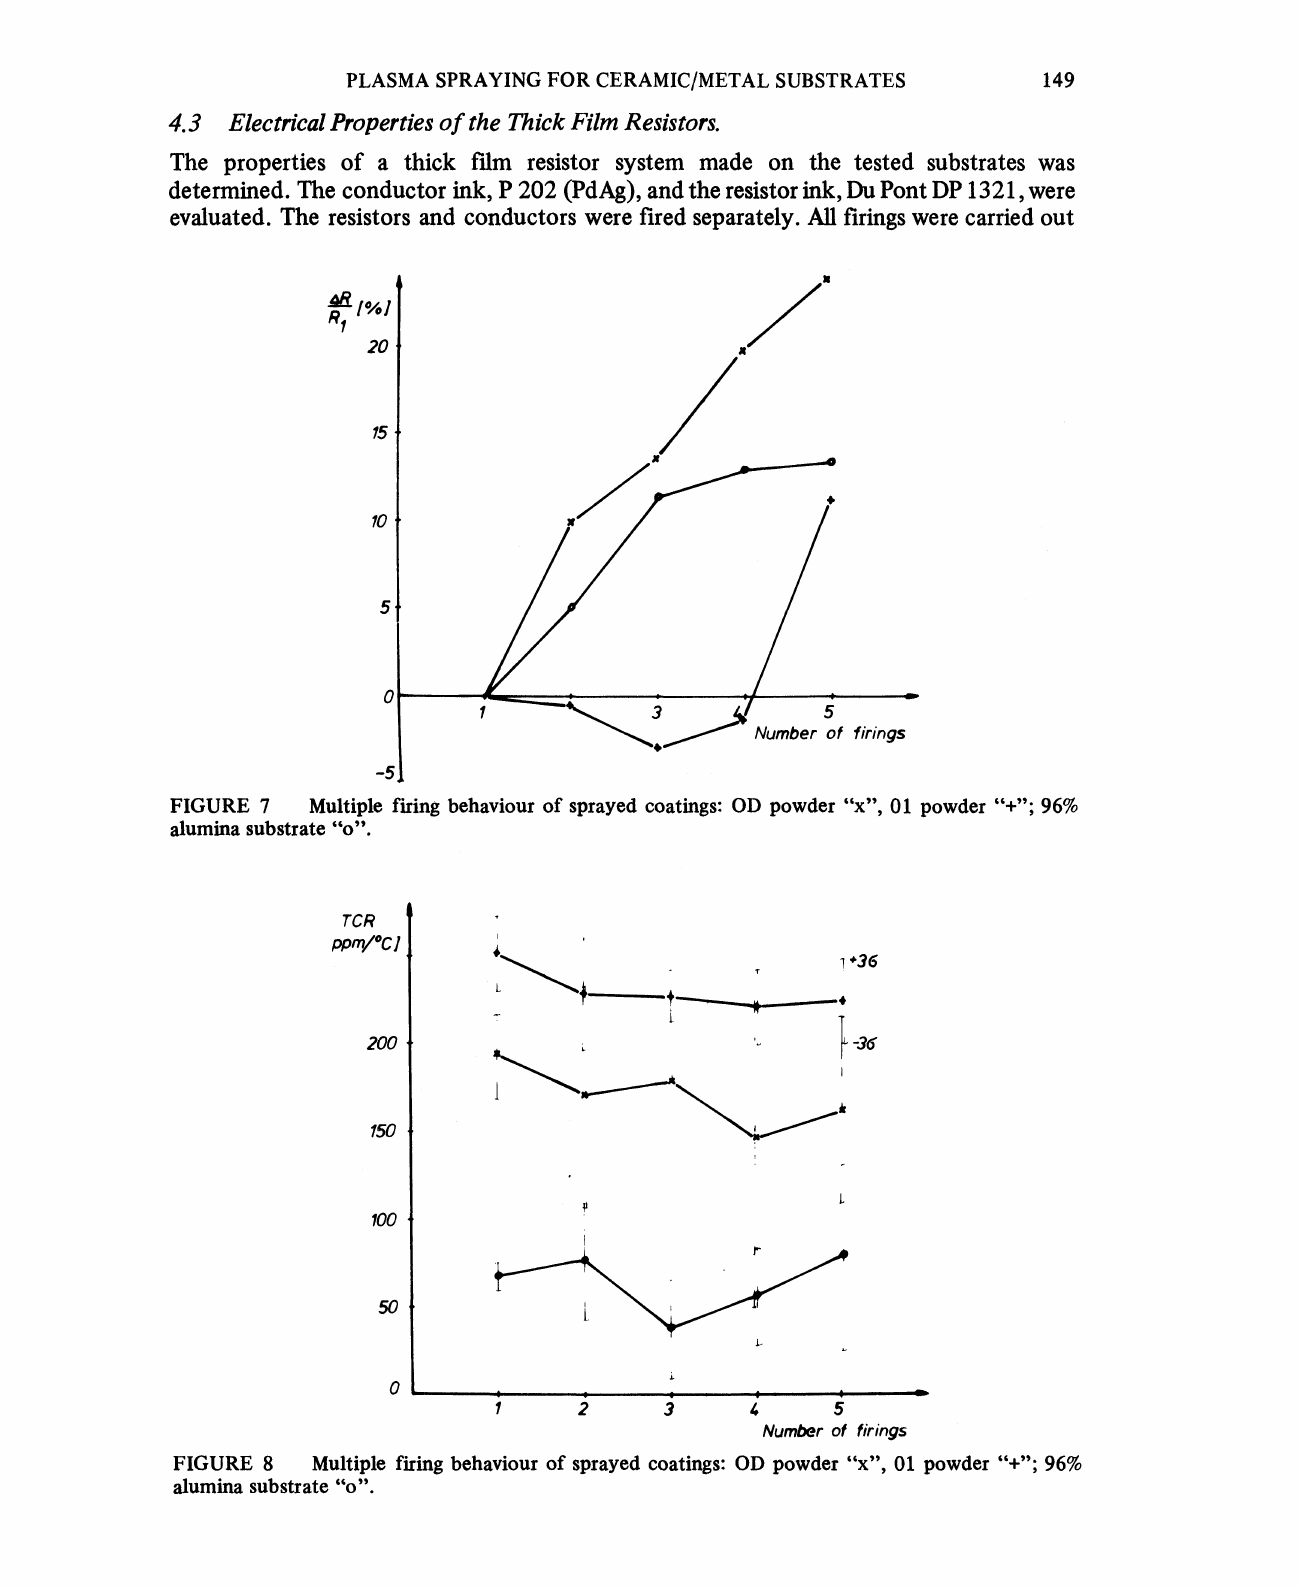
FIGURE 8 Multiple firing behaviour of sprayed coatings: OD powder "x", 01 powder "+"; 96% alumina substrate